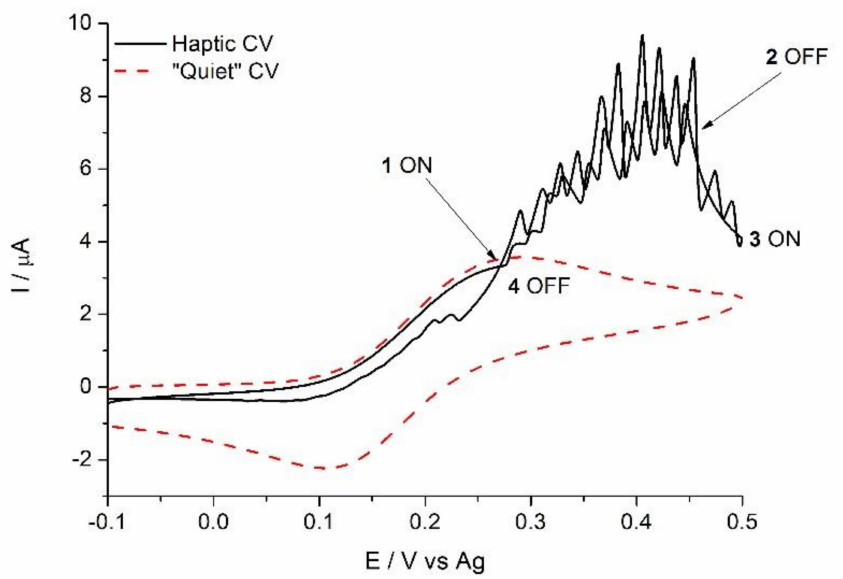
Figure 4. Haptic voltammetry. Cyclic voltammetry of 1 mM ferrocyanide in 0.1 M KNO 3 at a 2.5 mm screen-printed graphite disk electrode (scan rate 25 mV s − 1 ), shaken by a ringtone vibration (Haptic CV) and without vibration (quiet CV). The labeled points highlight the instant when the vibration starts or stops. Total solution volume was 60 µ